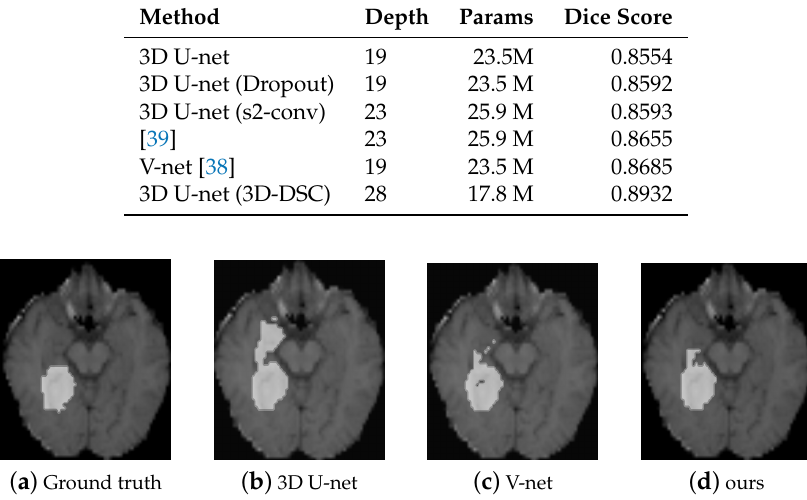
Figure 7. Example segmentation results on the BRATS 2017 Challenge dataset. From left to right: the ground truth, the segmentation result of 3D U-net, the segmentation result of V-net and the segmentation result of the proposed